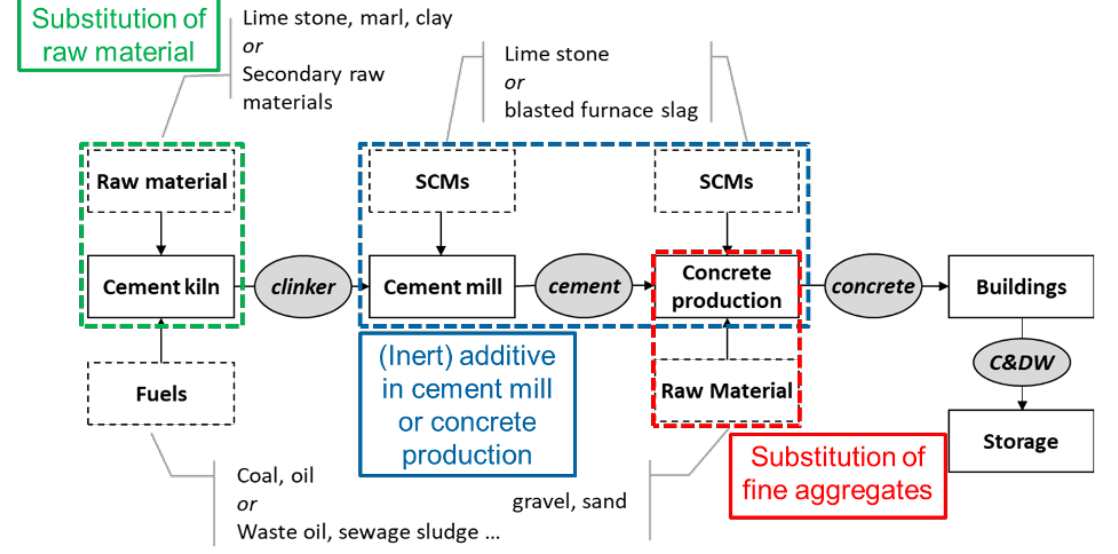
Figure 1. In the process chain, raw materials are used at various processes: in the cement kiln (green), in the cement mill/concrete production (blue) and in concrete production (red).